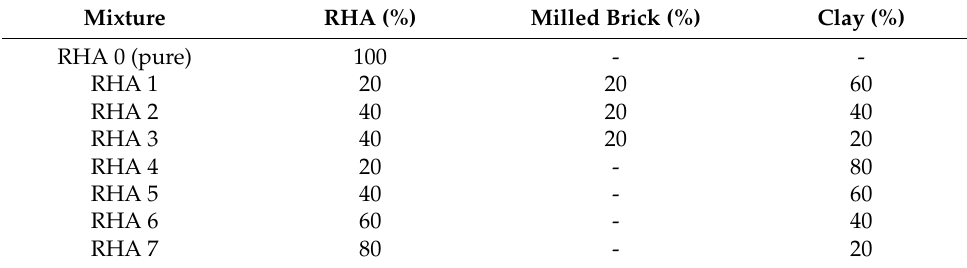
Table 4. Mix ratio for rice husk ash (RHA) used in lab